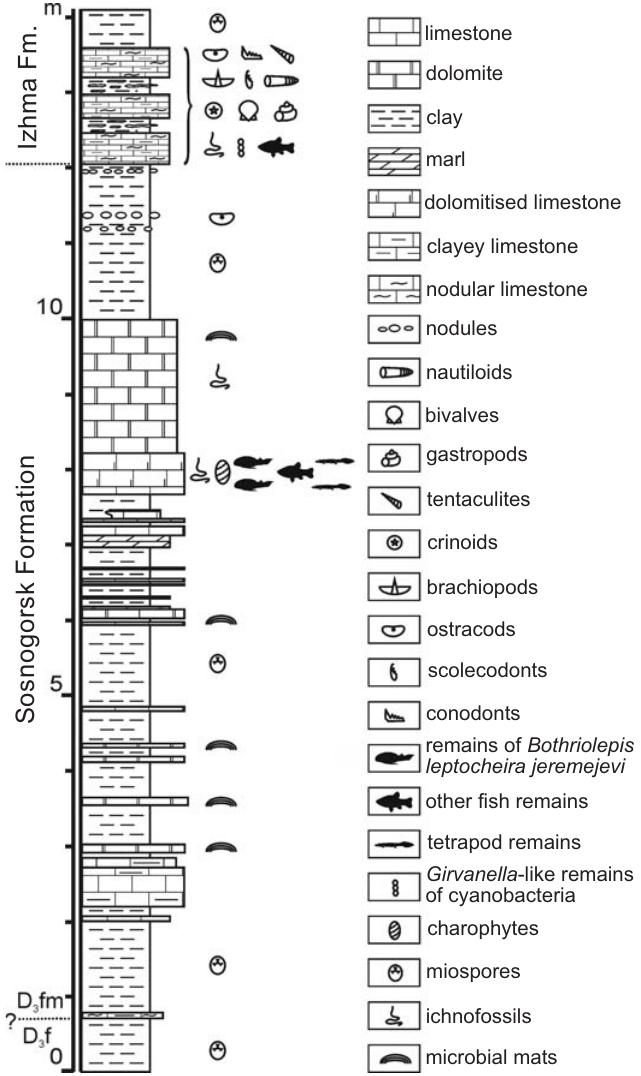
Fig. 2. Lithology and stratigraphy of the Sosnogorsk locality. “Fish-dolo- mite”, bed No. 40 is located about 8 m above the base of the section. Abbreviations: D 3 f, Upper Devonian, Frasnian; D 3 fm, Upper Devonian,